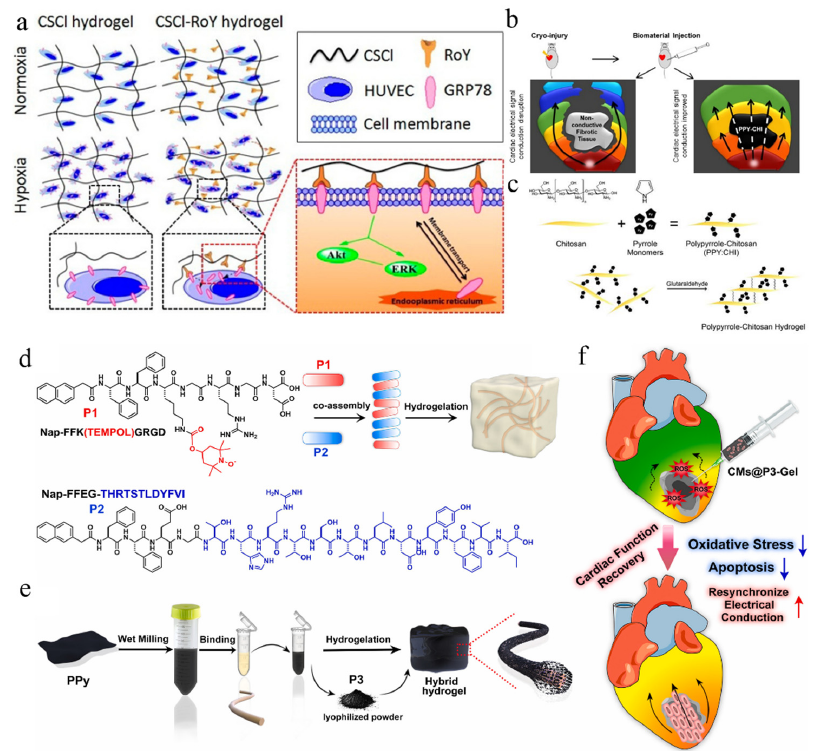
Figure 3. ( a ) Effect of CSCl-RoY hydrogel on the Akt and ERK signal transduction pathways.